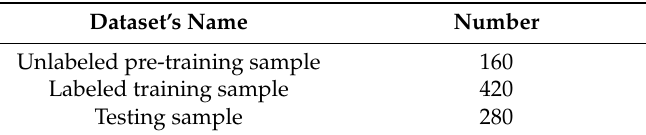
Table 2. Detail of dataset.